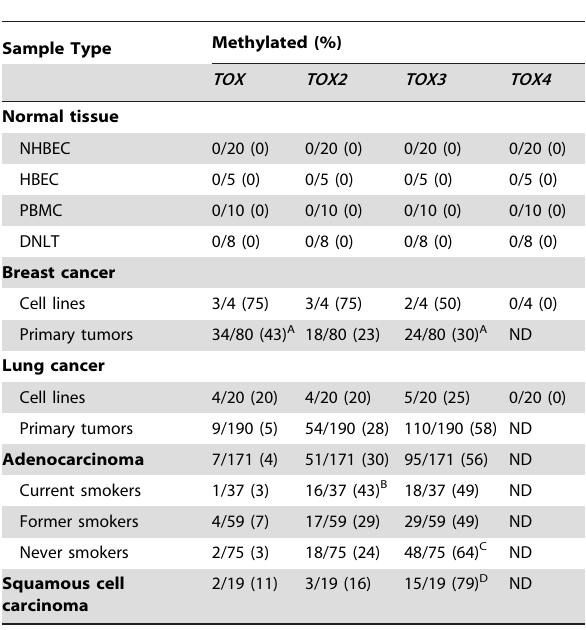
Table 1. Prevalence for promoter CpG island hypermethylation of TOX subfamily of